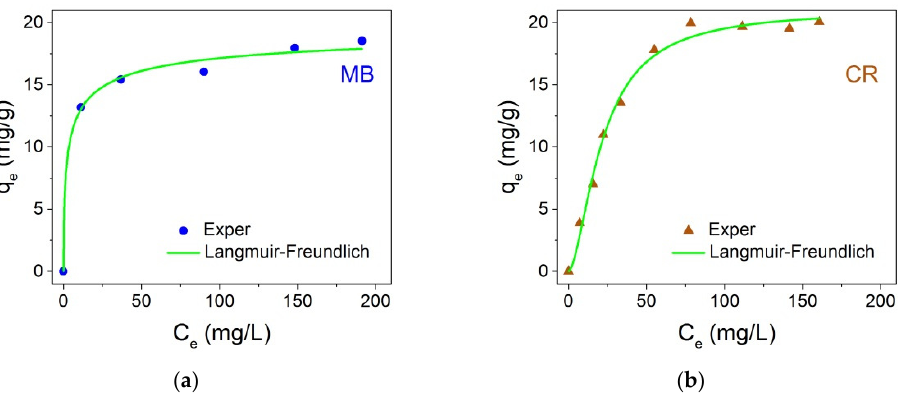
Figure 14. Adsorption isotherms for MB ( a ) and CR ( b ) dyes on the Fe 3 O 4 @C@C NPs at 25 °C.